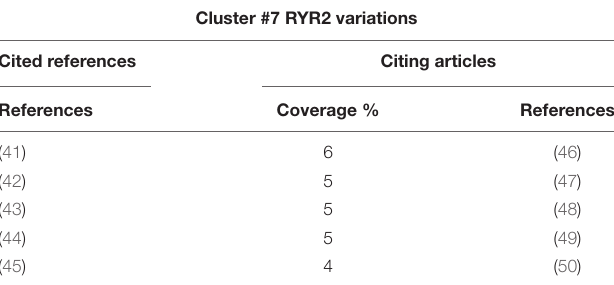
TABLE 5 | Cited references and citing articles of Cluster #7 RYR2